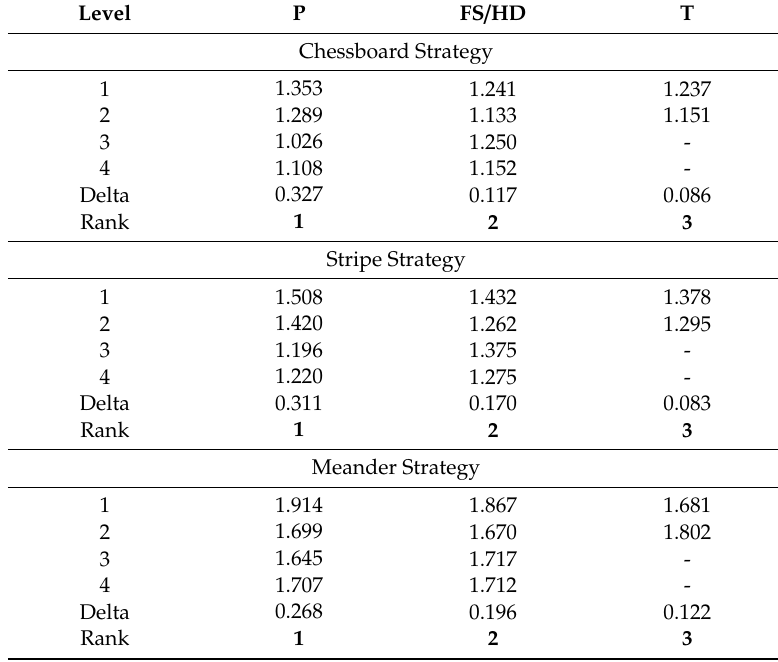
Table 5. Response table according Taguchi